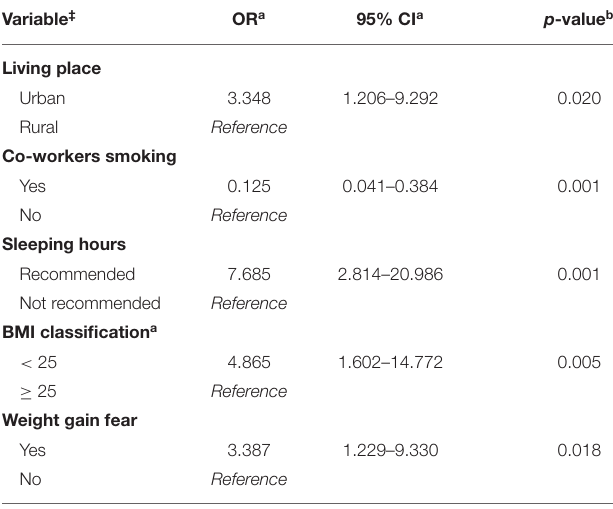
TABLE 4 | Logistic regression model for the study population according to